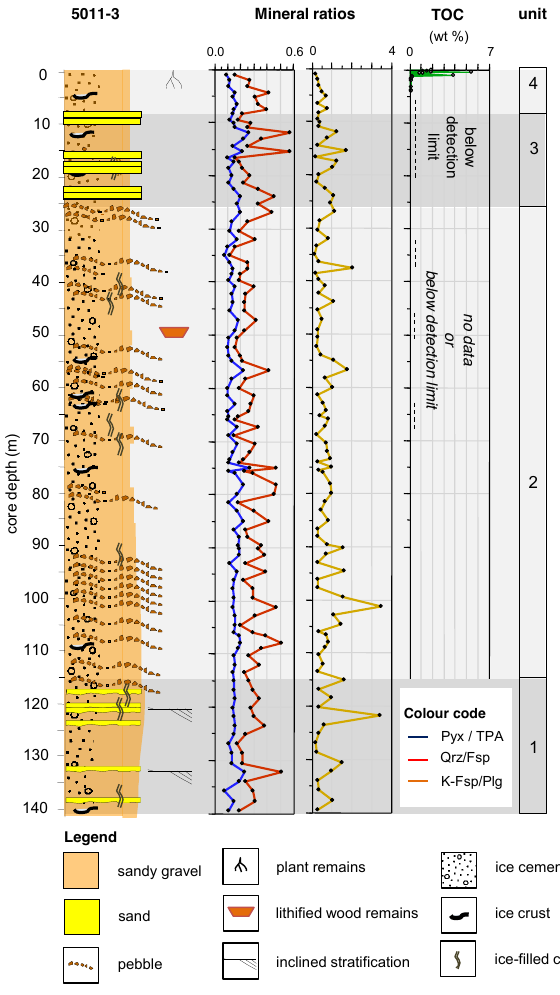
Fig. 4. Lithological log of core 5011-3 from El'gygytgyn Crater showing the material composition and the subdivision into core units based on macroscopic features. Abbreviations: Qrz = quartz, Fsp = feldspar, K-Fsp = Kali-feldspar, Plg = Plagioclase, Pyx = Pyroxene, TPA = total peak area.